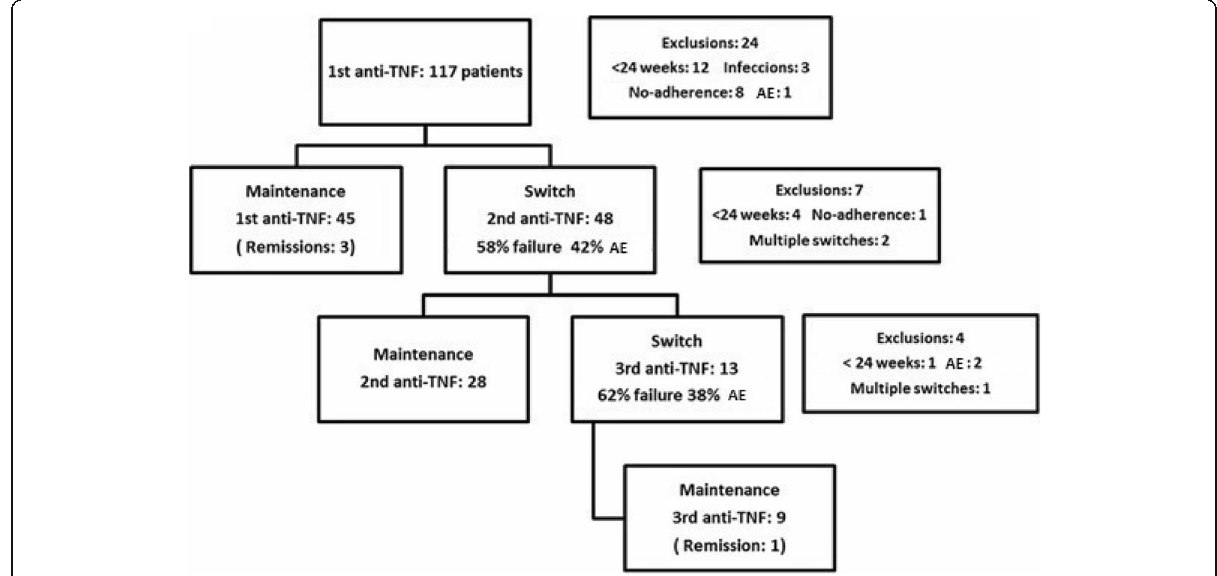
Fig. 1 Flow-chart of treatment courses in Ankylosing Spondylitis patients. AE: adverse